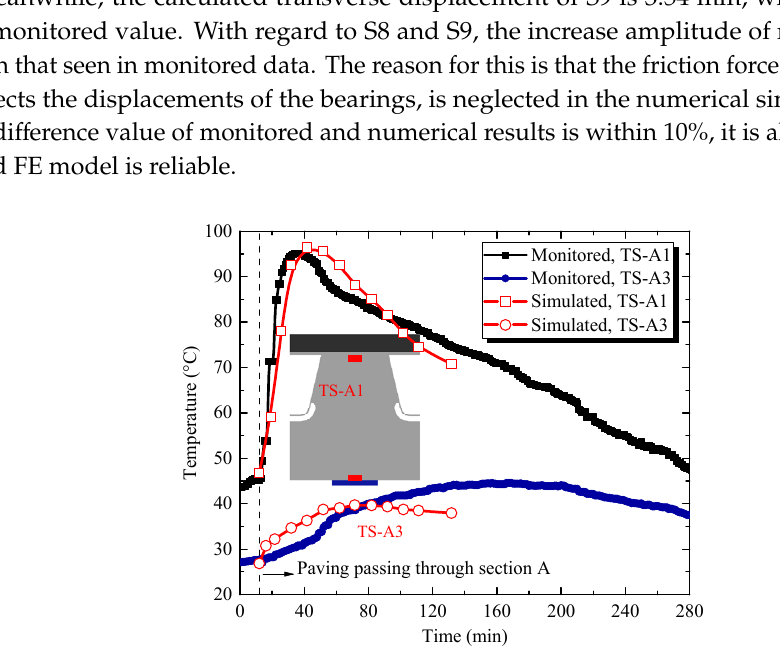
Figure 11. Comparison of monitored and numerical results of displacement of bearings.